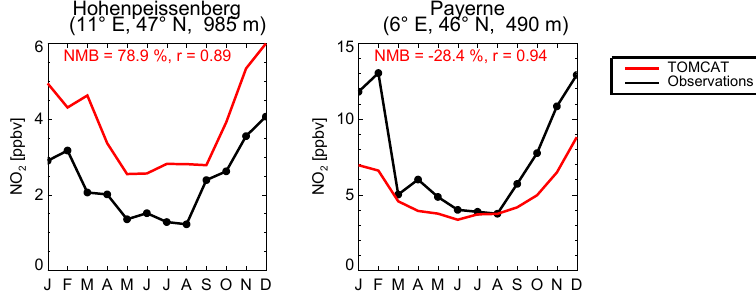
Figure 13. Monthly mean 2008 observed and simulated NO 2 (ppbv) at two European surface sites located in Europe. Pearson correlation ( r ) and normalised mean bias (NMB) between the observed and simulated monthly mean data are printed on each panel.